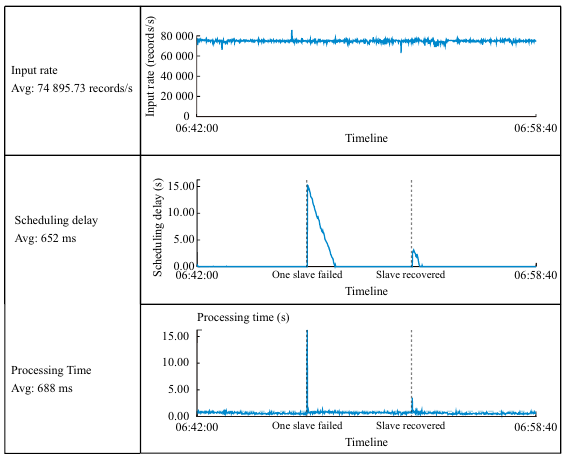
Fig. 6 System performance changes when a slave